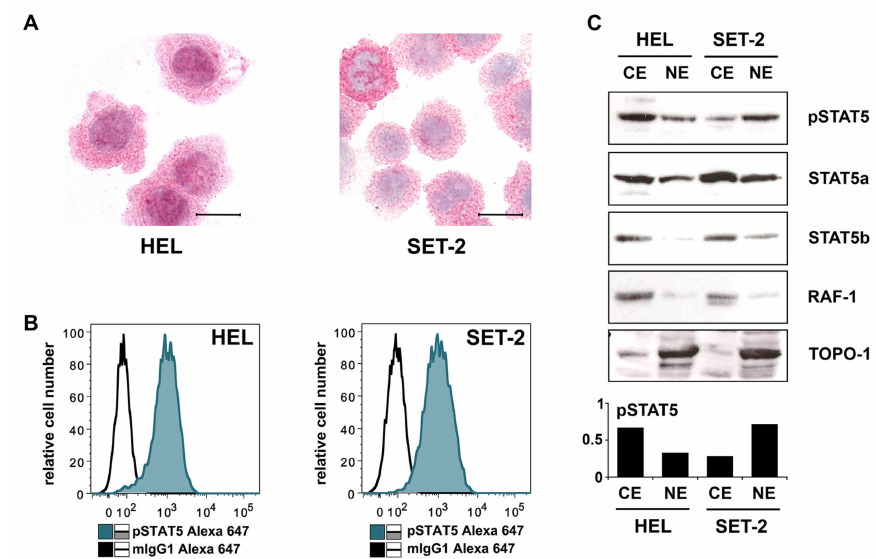
Figure 3. ( A ) Cytospin preparations of HEL cells and SET-2 cells were stained overnight with an anti-pSTAT5 antibody using immunocytochemistry. Scale bar: 20 µ M. ( B ) HEL cells and SET-2 cells were stained with an anti-pSTAT5 Alexa-647 antibody for 30 min at room temperature and intracellular expression levels were analyzed by flow cytometry. ( C ) Nuclear (NE) and cytoplasmic (CE) fractions of HEL or SET-2 cells were analyzed for expression of phosphorylated STAT5 (pSTAT5), total STAT5a and total STAT5b by Western blotting. Antibodies against RAF-1 (cytoplasm) and TOPO-1 (nucleus) were used as fraction controls. The columns show the densitometry for pSTAT5. Uncropped blots are shown in Figure